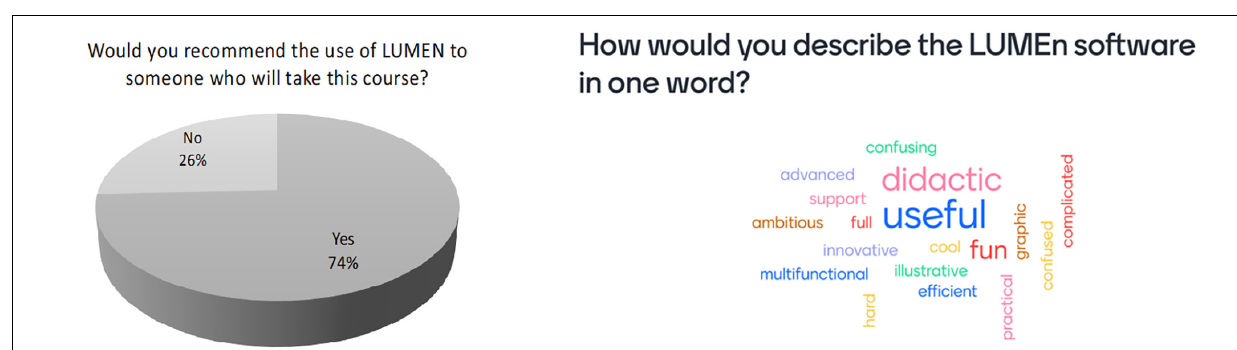
FIGURE 11 | Student opinion on